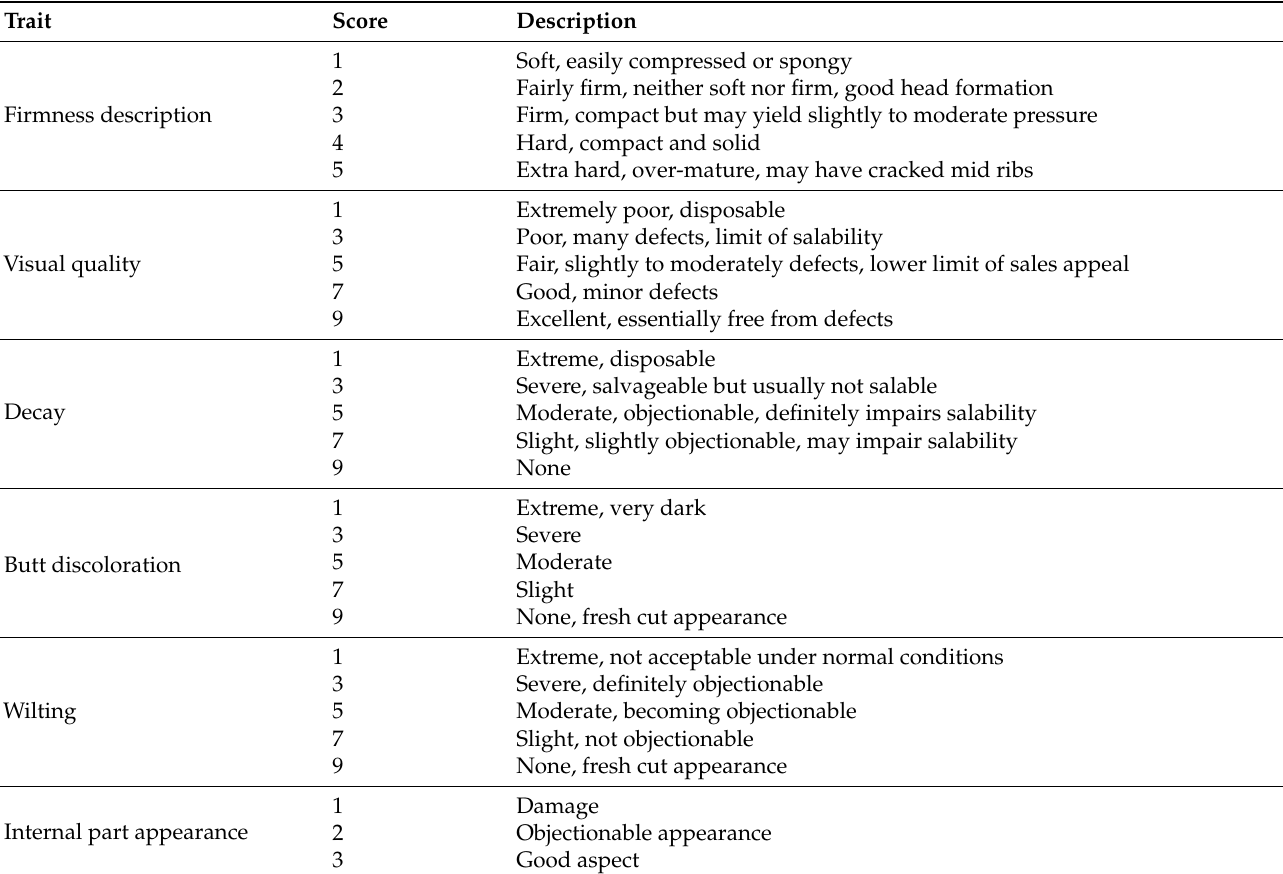
Table 2. Rating scale for the scoring visual quality of the harvested lettuce varieties.